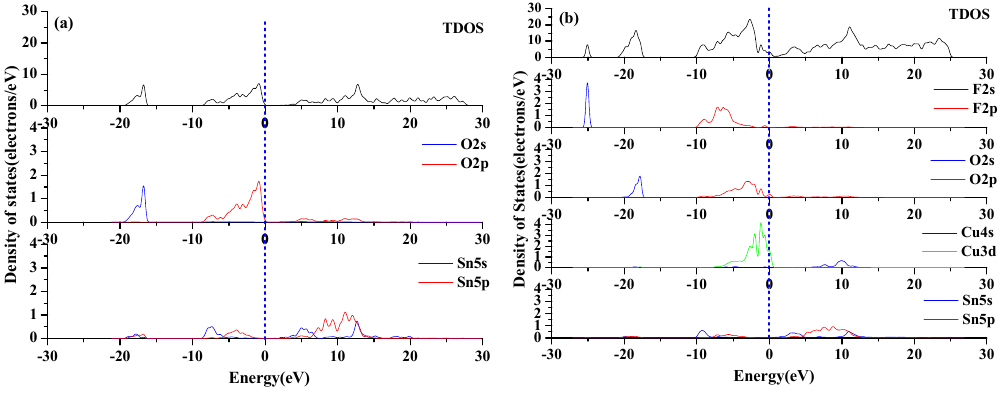
Figure 3. Density of states ( a ) intrinsic SnO 2 ; ( b ) SnO 2 -Cu-F.